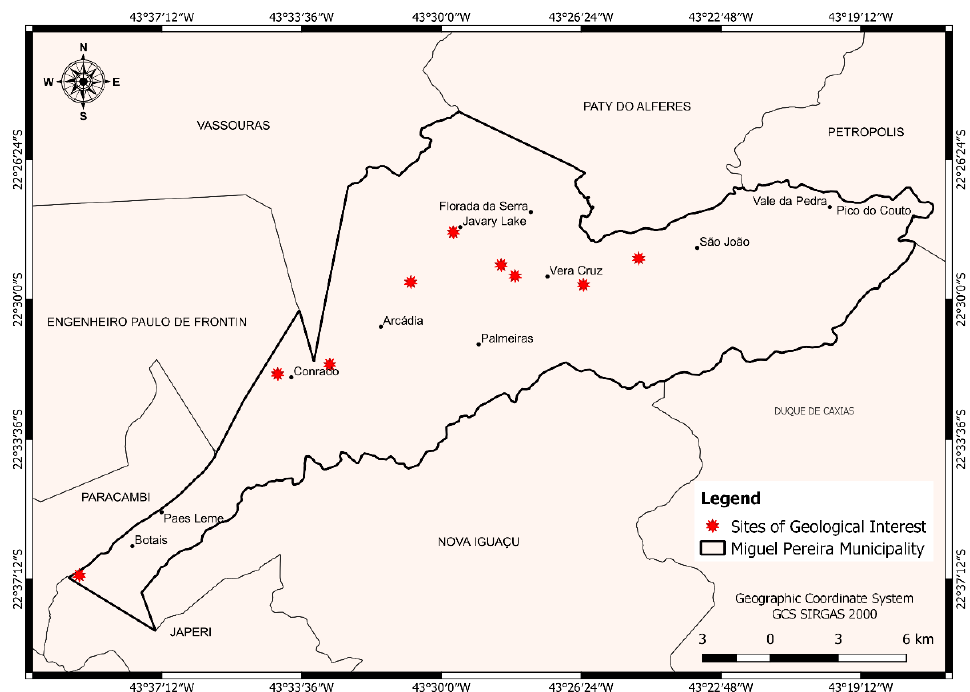
Figure 9. Sites of geological interest in Miguel Pereira municipality.